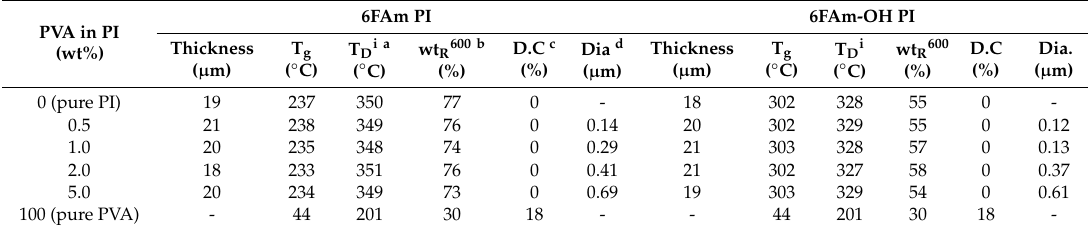
Table 1. Thermal properties of CPI membrane films with various PVA contents.